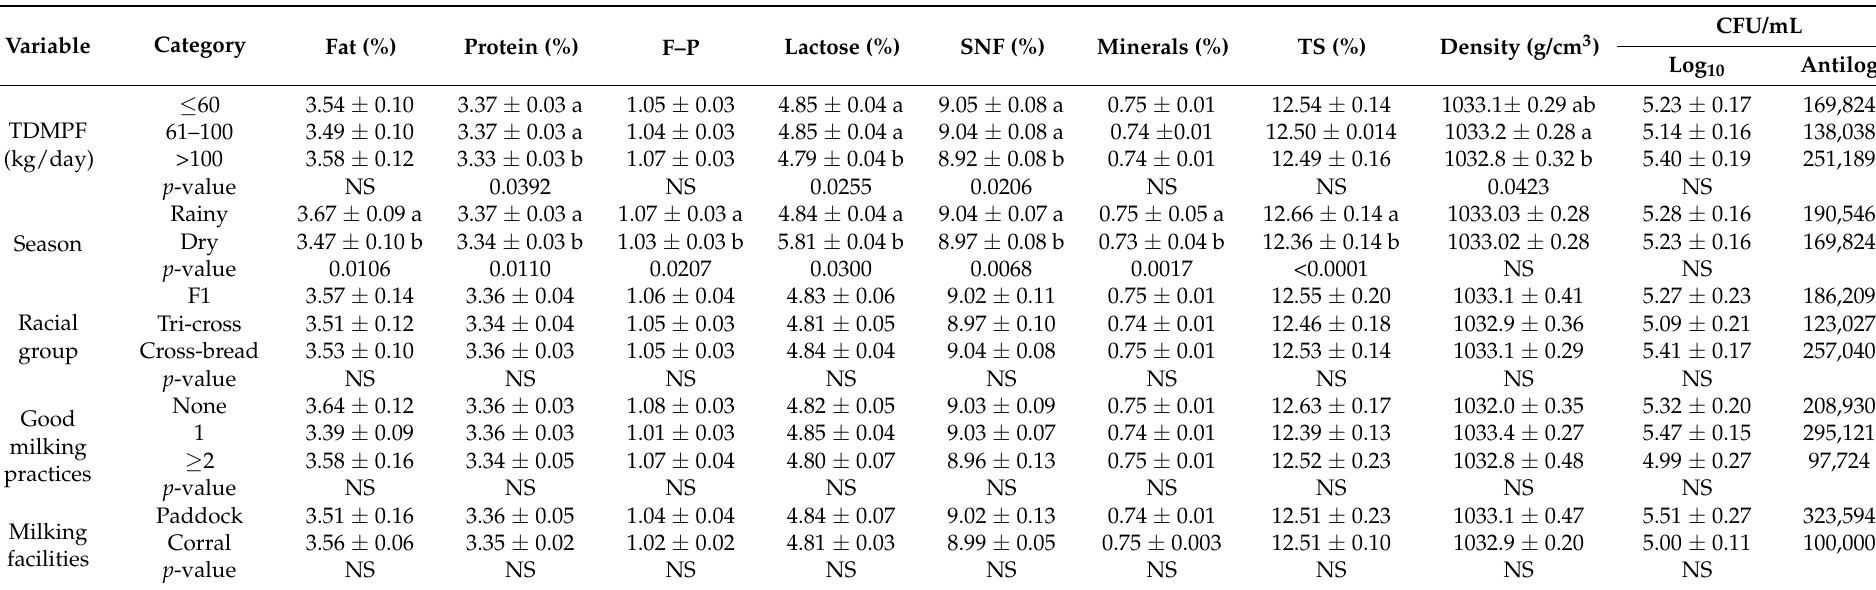
Table 2. Mean values of the studied effects on the milk chemical and microbiological quality in dual-purpose systems of the Arauquita